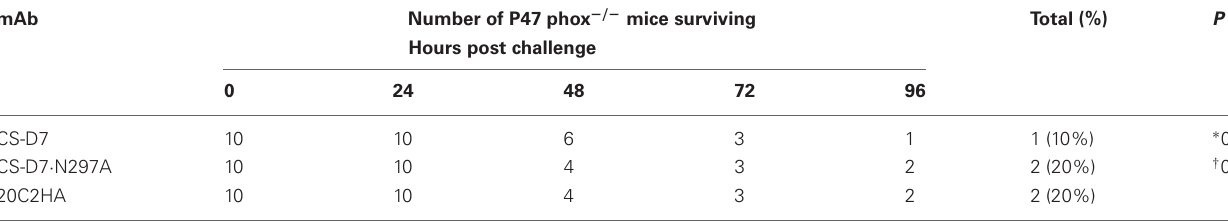
∗ Comparison of survival with CS-D7 versus survival with isotype control 20C2HA. † Comparison of survival with CS-D7 · N297A versus survival with CS-D7.